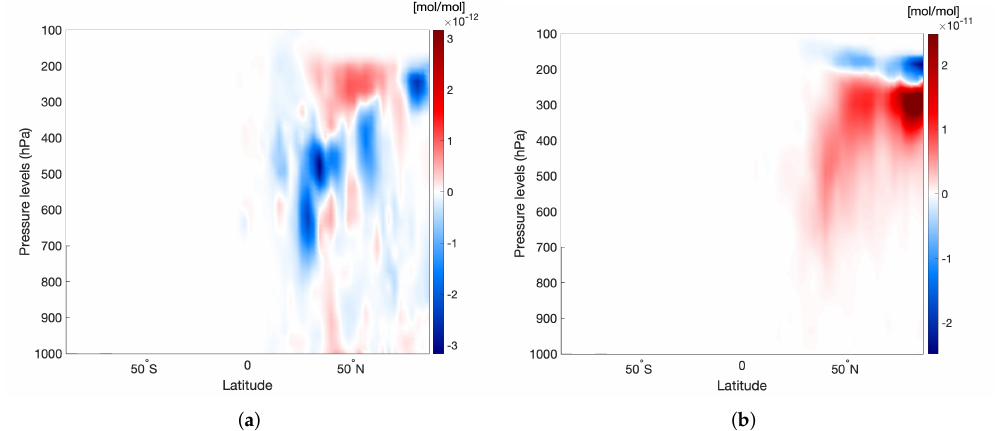
Figure 18. Difference of the zonal mean O 3 atf mixing ratio (mol/mol) between climate-optimised flights and cost-optimised flights on 8 August 2016, a week after the release of the emissions for ( a ) lateral re-routing and ( b ) vertical re-routing.